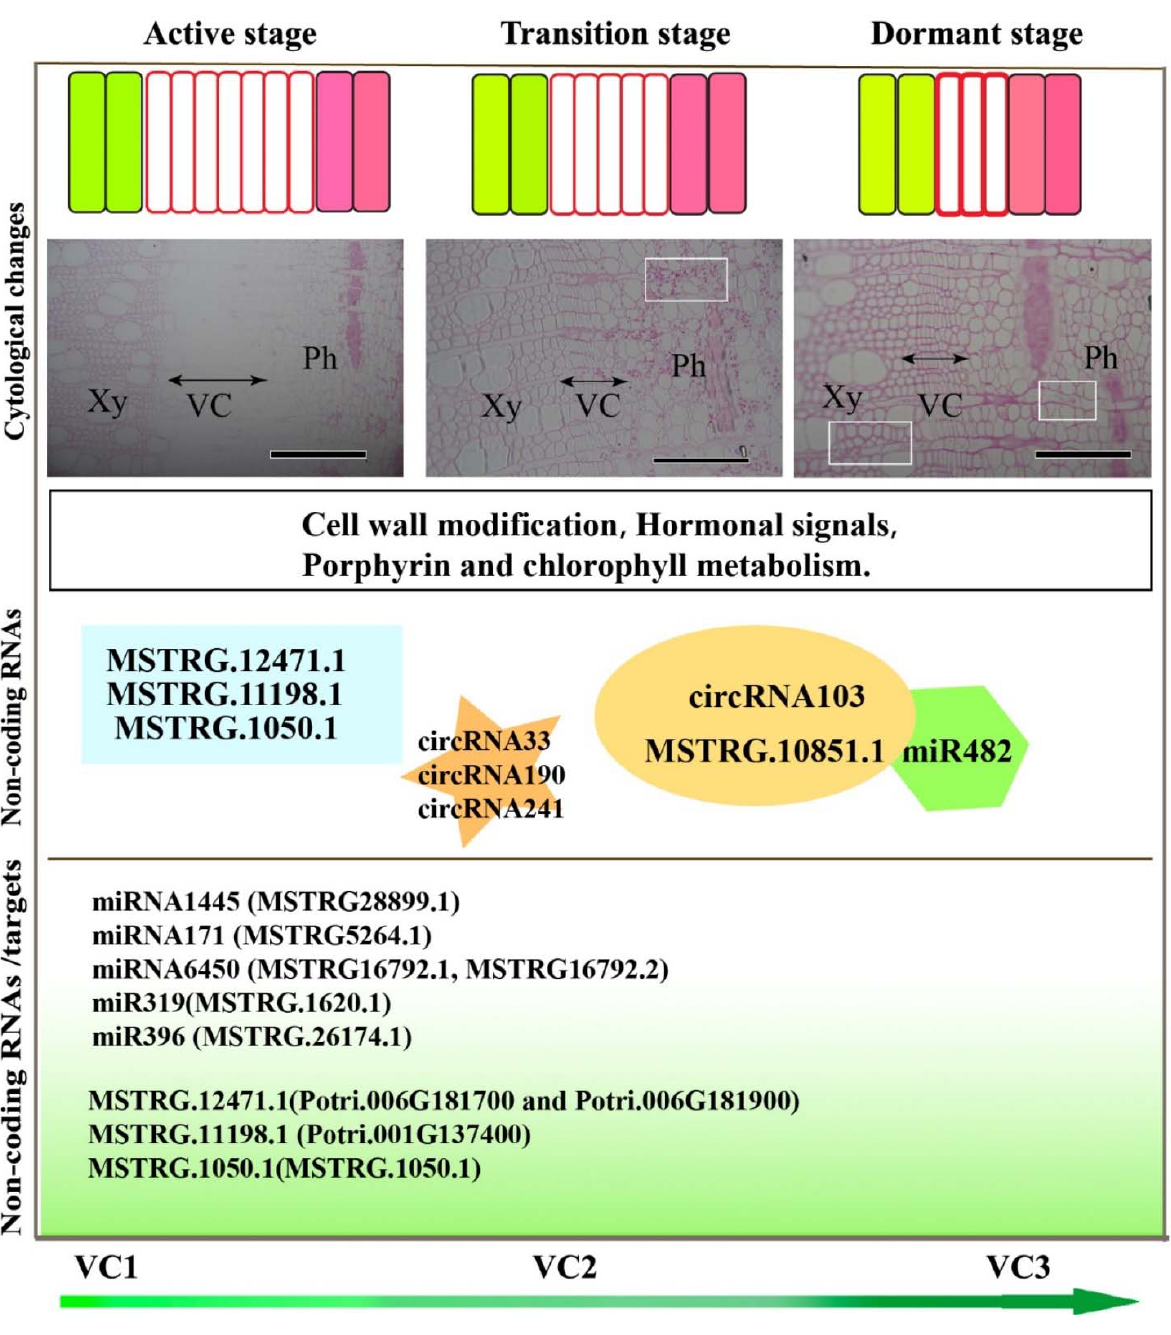
Figure 9. Diagram of the universal regulatory mechanisms of non ‐ coding RNAs in secondary meri ‐ stems in P. tomentosa during the active ‐ dormant transition. The cambium cell numbers and cell wall thickness are modified, which is related to gene expression and cytology. Non ‐ coding RNA regula ‐ tion of gene expression contributes to cell wall modification, hormone signals, and porphyrin and chlorophyll metabolism, for example, lncRNAs MSTRG.12471.1, MSTRG.11198.1, and MSTRG.1050.1; and circRNAs circRNA33, circRNA190, and circRNA241. circRNA103 interacted with MSTRG.1050.1 and miR482. The non-coding RNAs and their targets are shown in the diagram. The light microscopy images are from Figure 1. Xy, Xylem; Ph, Phloem; VC, Vascular cambium. Bars in the microscopy images represent 200 µ